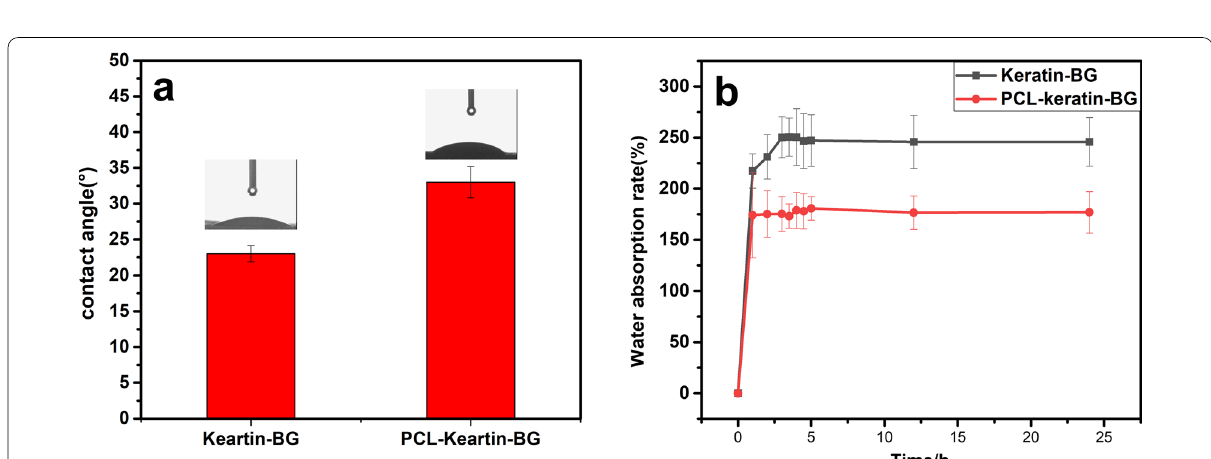
Fig. 5 a Contact angle and b water absorption rate of keratin-BG and